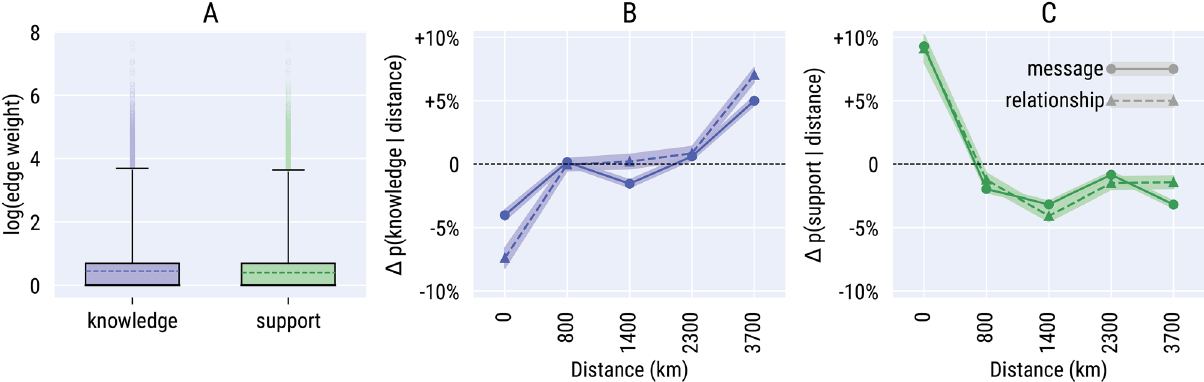
Figure 1. ( A ) Boxplots of the weight distributions of ties that exchanged at least one message of knowledge or one message of support , on a logarithmic scale. Boxes represent the two mid quartiles of the distributions, with the median marked with a dashed line. The whiskers show the 99th percentiles of the distributions. ( B , C ) Percent change � p ( d | l ) of the probability that a dimension d is expressed by a social tie spanning a geographical distance l , compared to random chance. The change is estimated by comparing the real data with distance measurements on 50 instances of a null model that reshuffled user locations at random; the average values along with their 95% confidence intervals are reported. Distances are discretized in five bins, each containing the same number of social ties. Bins are labeled with the median distance of the ties inside that bin. The ‘zero distance’ bin contains almost exclusively pairs of users who live in the same state. Two types of measurements are presented: (i) at the level of social relationships, where each social tie is counted once regardless of its weight, and (ii) by performing a distance measurement for each individual message, thus effectively weighting more pairs of users who communicated